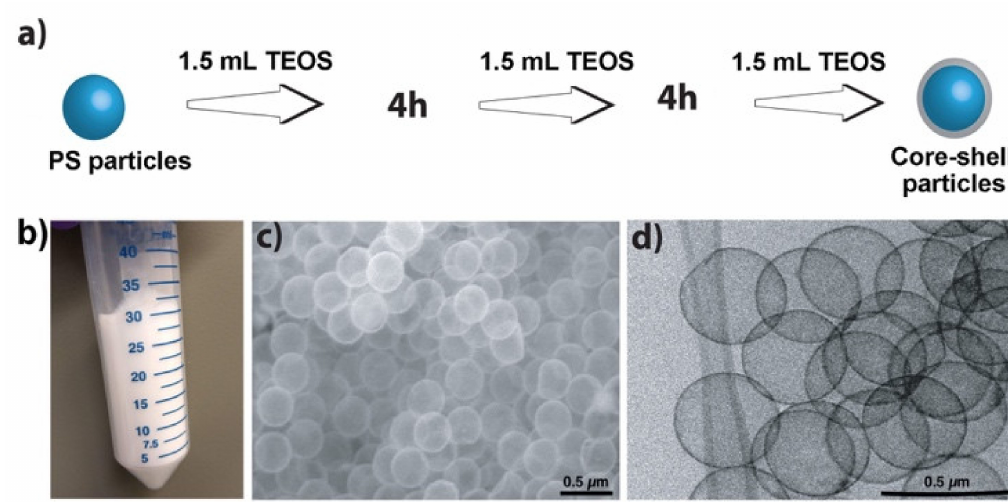
Figure 1. ( a ) Schematic showing the stepwise addition of TEOS at an optimum concentration to form silica shells around the PS particles at a high concentration. ( b ) Hollow particles synthesized from 100 mL of isopropanol. ( c ) SEM and ( d ) TEM images of the same hollow particles. Note: Schematic shows only the core-shell particle formation. The step of burning the PS cores to obtain hollow silica particles is not